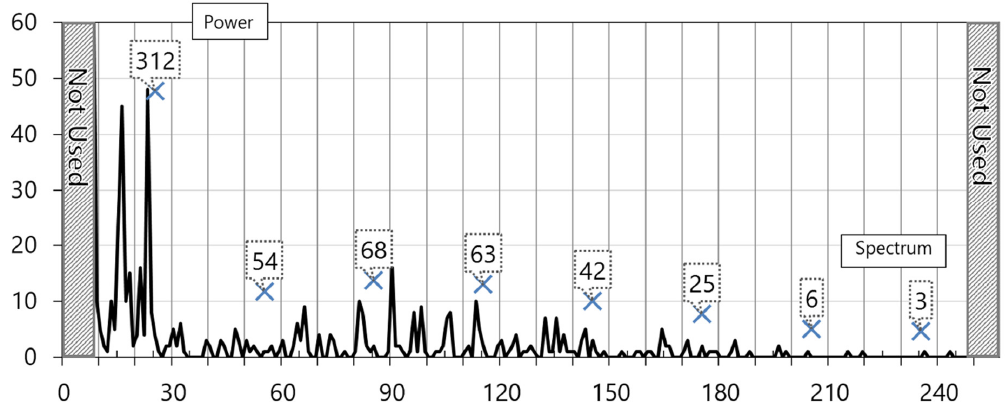
Figure 3. Graph of power spectrum extracted from normal ECG data by fast Fourier transform. The left and right diagonal lines of the graph are removed. The X mark in the unit of 30 means the cumulative value of spectrum strength after the segmentation of sections except for noise sections.